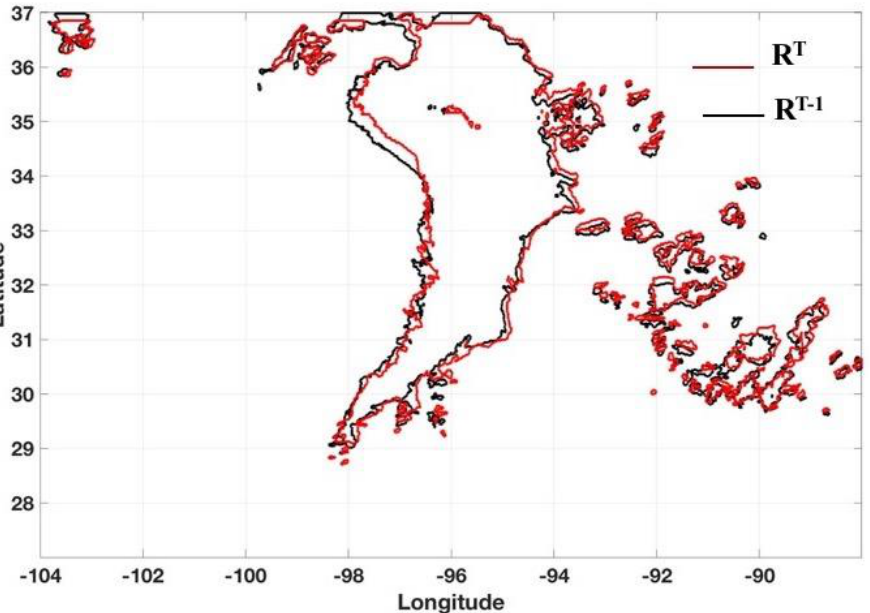
Figure 4. The contours of the rainfall rate ( R ) fields. The segmentations of R at 2210 UTC ( R T ) and 10 min prior ( R T − 1 ) are represented by red and black lines, respectively.